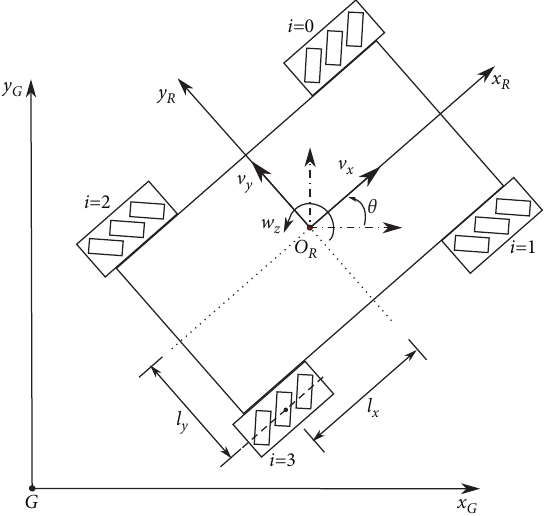
Figure 12: Vehicle model used for the calculation of inverse and forward kinematics.